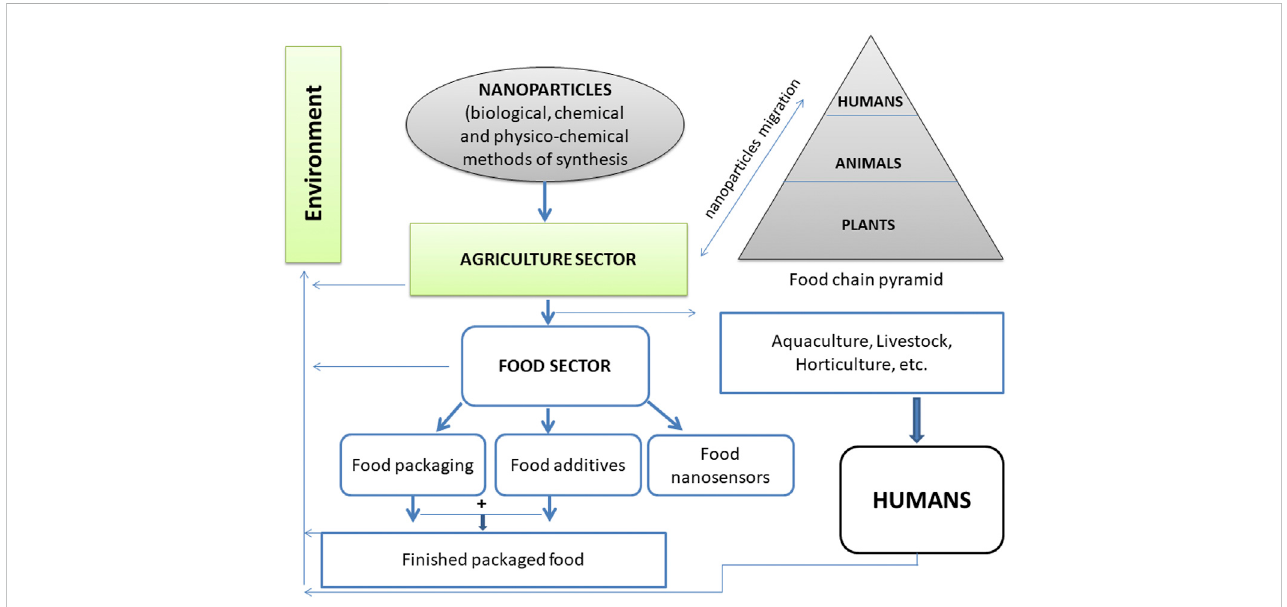
FIGURE 7 A proposed typical cycle of migration of nanoparticles from their source of synthesis to the agriculture sector, and then fi nally accumulate inside the human body through the fi nished packaged food.